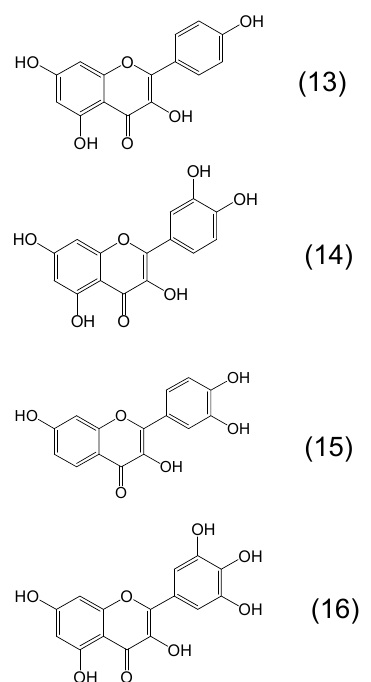
Figure 5. Examples of phytochelators with the flavonoid chemical structure. Kaempferol or 3,5,7-trihydroxy-2-(4-hydroxyphenyl)-4 H -chromen-4-one ( 13 ), quercetin or 2-(3,4-dihydroxyphenyl)- 3,5,7-trihydroxy-4 H -chromen-4-one ( 14 ), fisetin or 2-(3,4-dihydroxyphenyl)-3,7-dihydroxychromen- 4-one ( 15 ), myricetin or 3,5,7-trihydroxy-2-(3,4,5-trihydroxyphenyl)-4-chromenone ( 16 ).